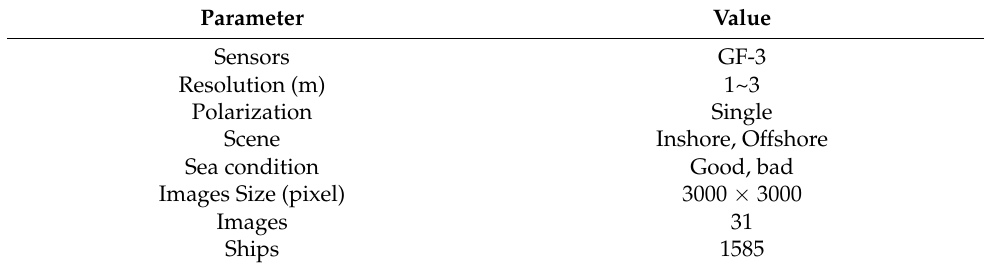
Table 4. AIR-SARShip dataset.